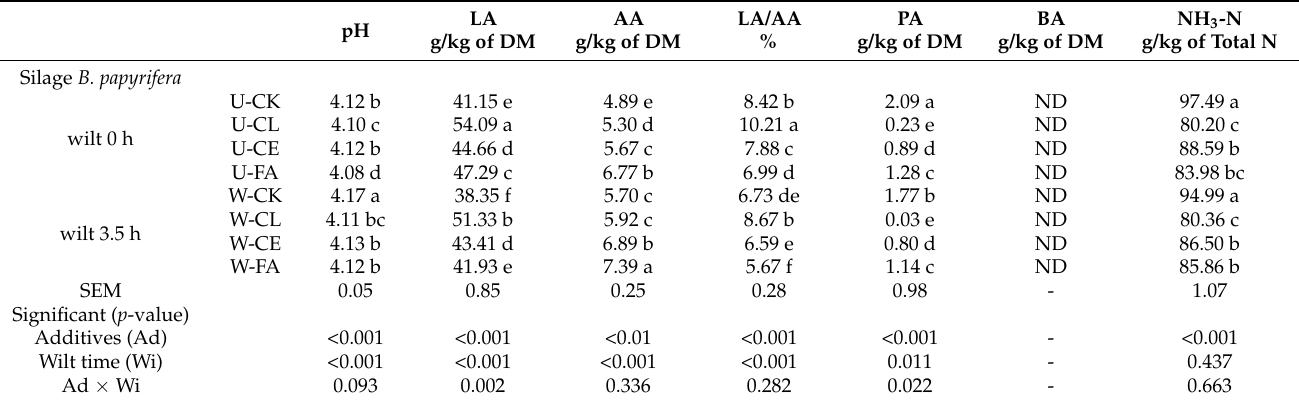
Table 3. The fermentation characteristics of B. papyrifera silage with